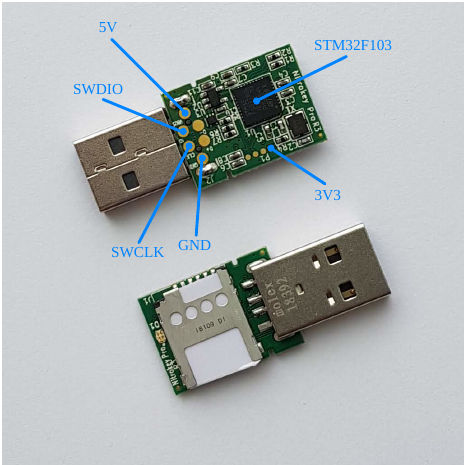
Figure 3: Front (top) and back side (bottom) of the Nitrokey Pro 2. The integrated microcontroller and the accessible supply and debug pins are